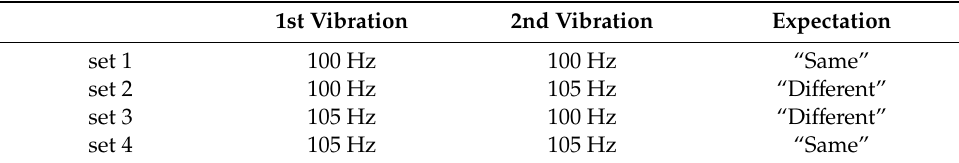
Table 1. Patterns and the expected answers of the first experiment.